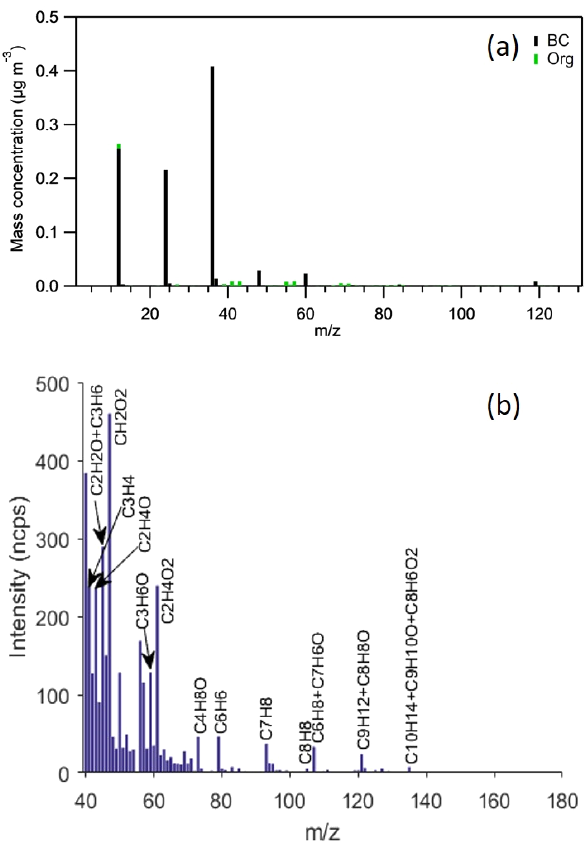
Figure 2. The average particle-phase mass spectrum of pure vehicle exhaust measured inside the chamber right after the feeding period, before BL lamps were switched on (AMS data; a ). The average gas- phase mass spectrum of all Pure vehicle and Mixed experiments after the exhaust feeding period (PTR-ToF-MS data; b ). The in- strument background, measured through active carbon, is subtracted from the gas-phase mass spectrum, and the water triplet signal from m/z 55 is removed for clarity. Gas-phase mass spectrum intensity is normalized against the primary ion (H 3 O + ) signal intensity of 10 6 cps (cps – counts per second; ncps – normalized counter per